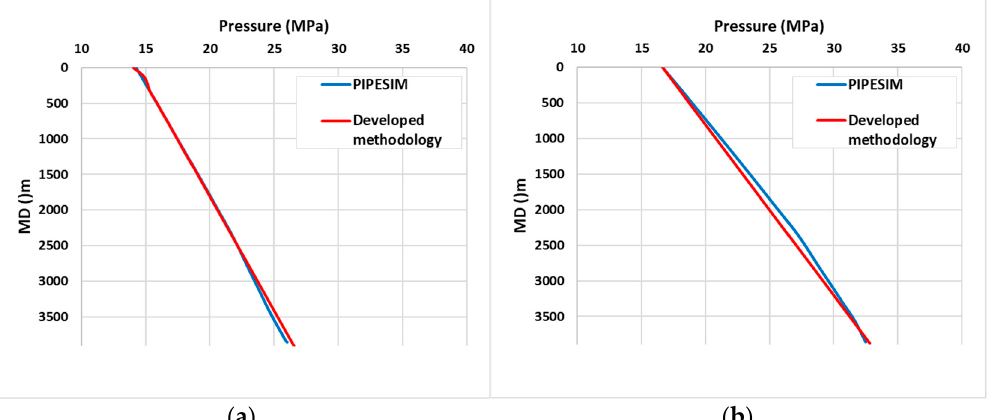
Figure 7. Pressure distribution along the wellbore. The blue line represents the result of the PIPESIM calculation, while the red line represents the result of the calculation of the proposed model. The black oil model is ( a ), while the compositional model is ( b ).